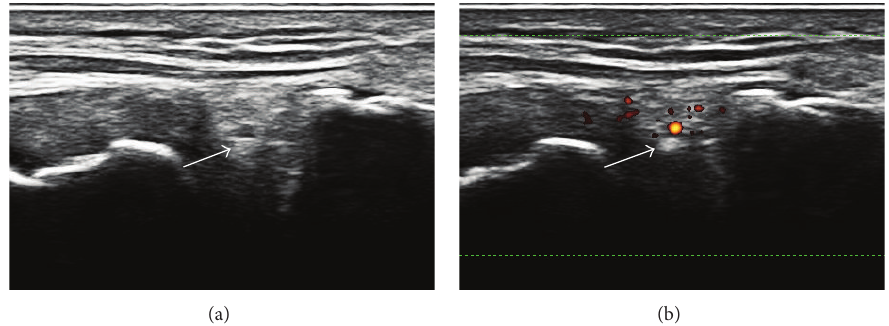
Figure 4: Small hyperechogenic deposit in a medial meniscus (arrow). Power Doppler US highlights the presence of a small vessel just above the focal hyperechogenicity, stressing the probability of posterior enhancement due to the presence of blood (water) in the vessel.